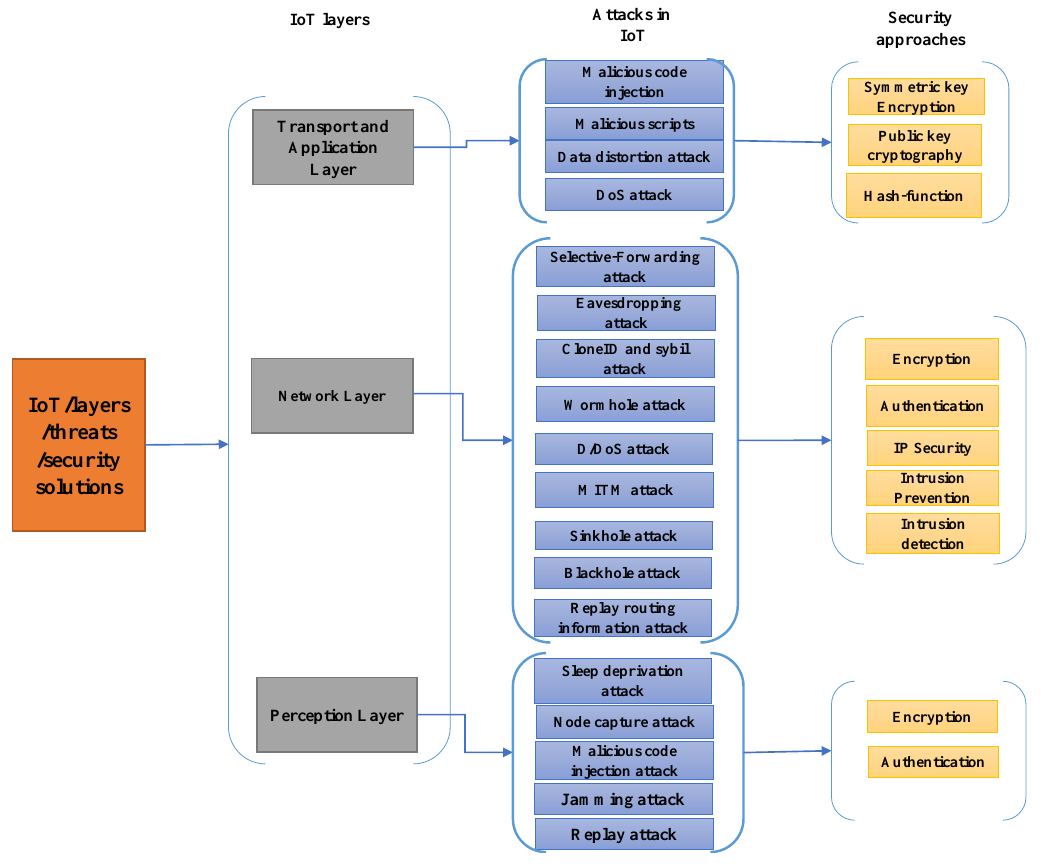
Figure 2. Classification of IoT layers, threats and security